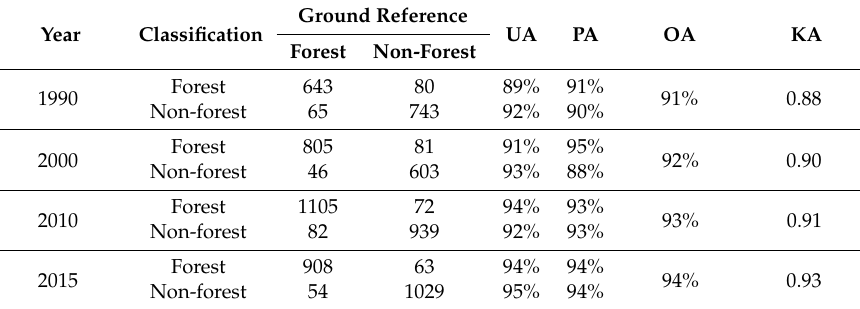
Table 2. Accuracy assessments of the forest classification in northeast